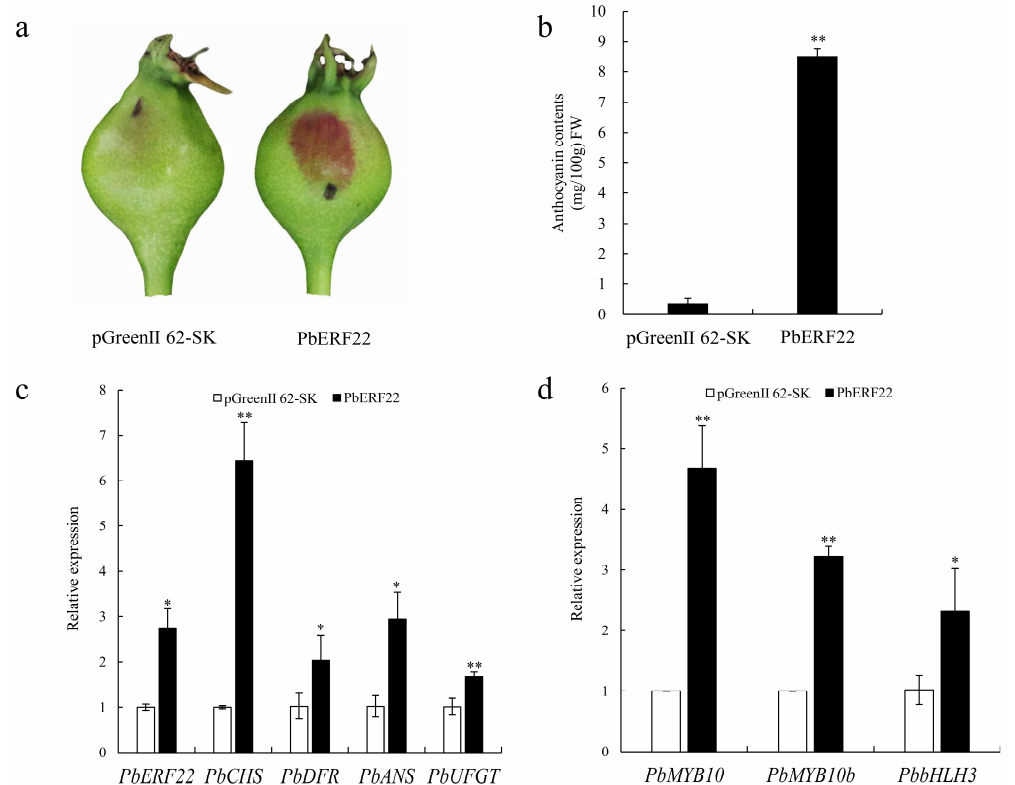
Figure 5. Transient transformation assays verifying PbERF22 ’s function in the coloration of ‘Zaosu’ fruit peel. ( a ) The phenotype of the ‘Zaosu’ pear 7 d after overexpressing PbERF22 and the empty vector (pGreenII 62-SK), which were introduced by infiltration; ( b ) Measurements of anthocyanin contents in the injection regions of fruit peel; ( c ) qRT-PCR analysis of the expression levels of anthocyanin structural genes after infiltration; ( d ) The expression levels of anthocyanin regulatory genes. * indicates significant differences at p < 0.05, ** indicates significant differences at p < 0.01. Error bars represent ± SDs of three biological replicates.